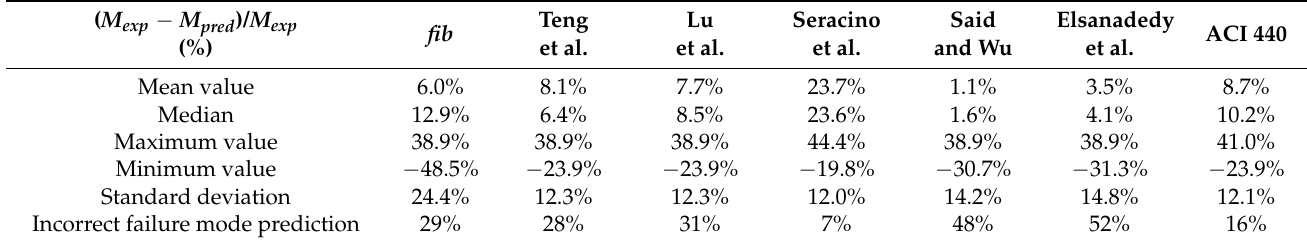
Figure 11. Comparison of deviation of predicted results — box plots. Table 3. Comparison of deviation of predicted results.